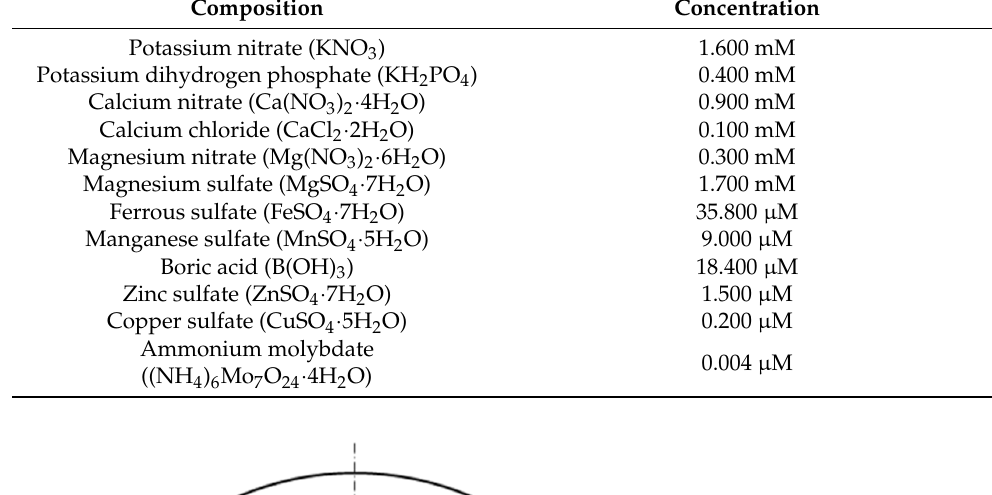
Table 1. The composition and concentration of the standard solution of MINA fertilizer [14].